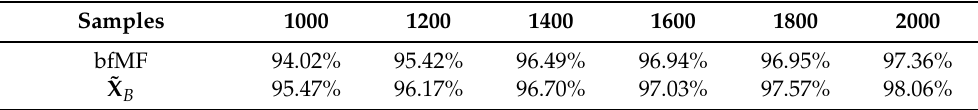
Table 5. Classification accuracy based on different input datasets under